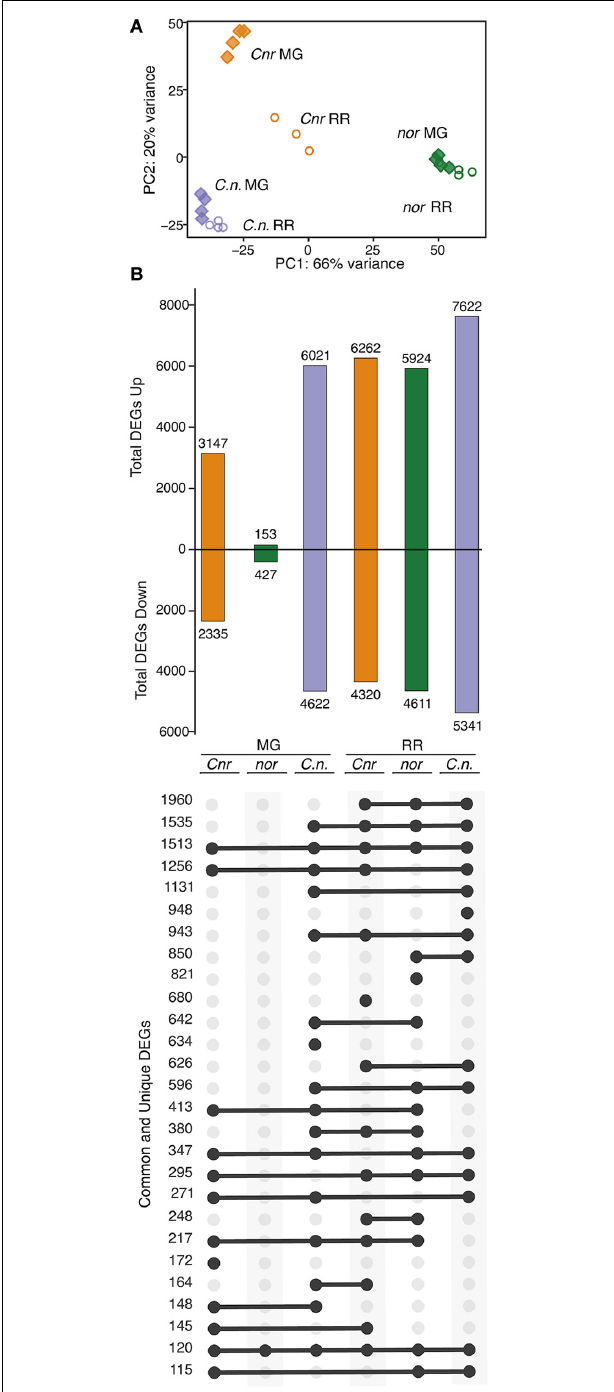
FIGURE 6 | Comparison of Cnr/nor double mutant gene expression to parents. (A) Principal component analysis of total mapped RNAseq reads for the double mutant Cnr/nor ( C.n. ), and the parents Cnr and nor at the mature green (MG) and red ripe (RR) stages. (B) Total, unique, and intersecting differentially expressed genes (DEGs) compared to wild type (WT) for each genotype (mutant/WT) visualized using UpSetR . Dots connected by lines indicate common DEGs between categories and single dots indicate unique DEGs, with the numbers of shared or unique genes at the